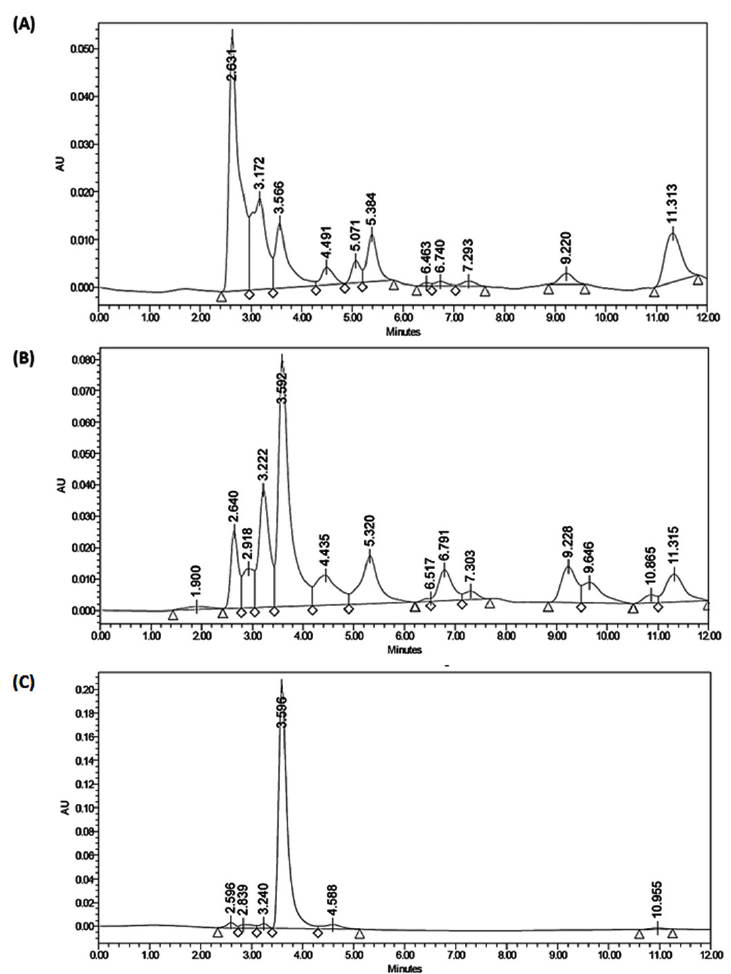
Fig. 3. HPLC analysis of organic acids secreted by selected isolates as by-products of aerobic L-tartrate metabolism Representative HPLC chromatograms of cell free culture supernatants of (A) IC1-G and (B) IC1-Y isolates grown for 48 h on L-tartrate as sole carbon source (C) initial 0 h growth medium containing